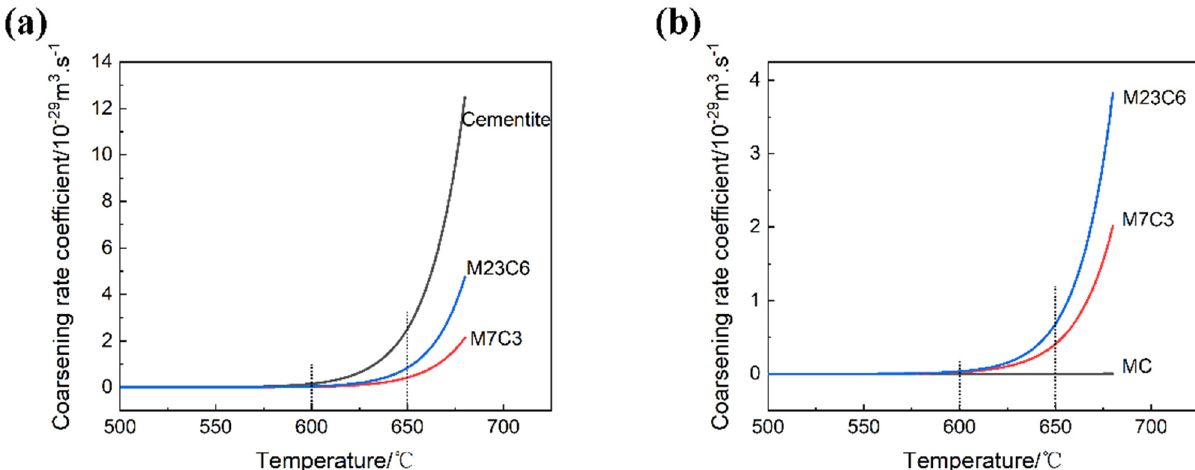
Figure 10: The in fl uence of temperature on carbide coarsening rate coe ffi